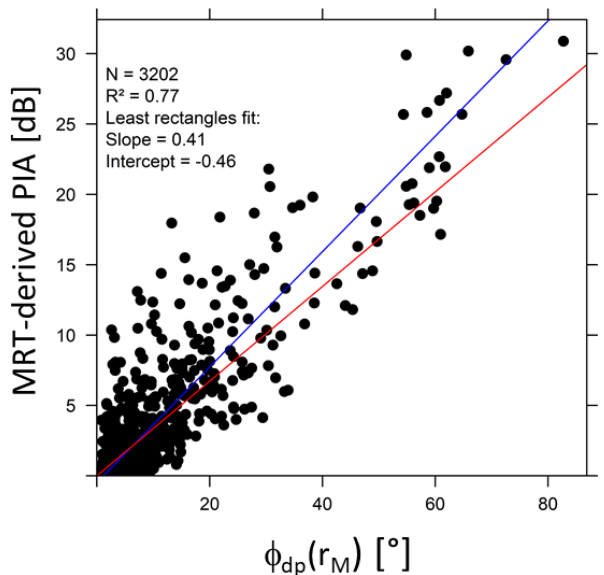
Figure 9. PIA– φ dp scatterplot for the nine convective events consid- ered in this study. The blue line corresponds to the least rectangle fit to the data, while the red line corresponds to the linear k – K dp relationship derived from the DSD data available at ground